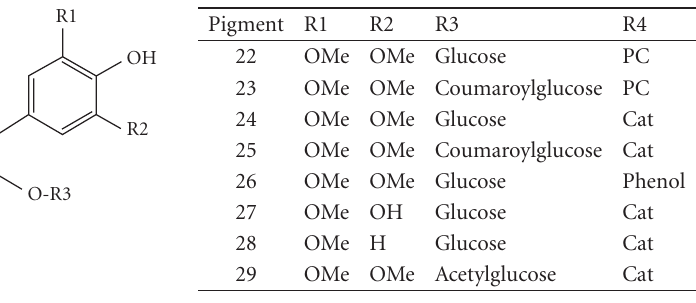
Indeed, despite the extensive colour palette available in nature, pigments exhibiting blue colours are very